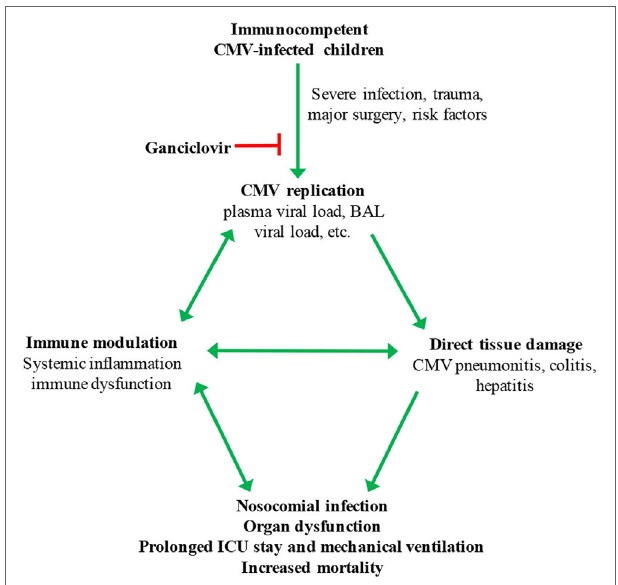
FigUre 1 | Hypothesized model for cytomegalovirus (CMV) reactivation in critically ill children. Possible risk factors for systemic CMV replication include severity of illness, pneumonia, malnutrition, blood transfusion, corticosteroid treatment, and young age. BAL, bronchoalveolar lavage.